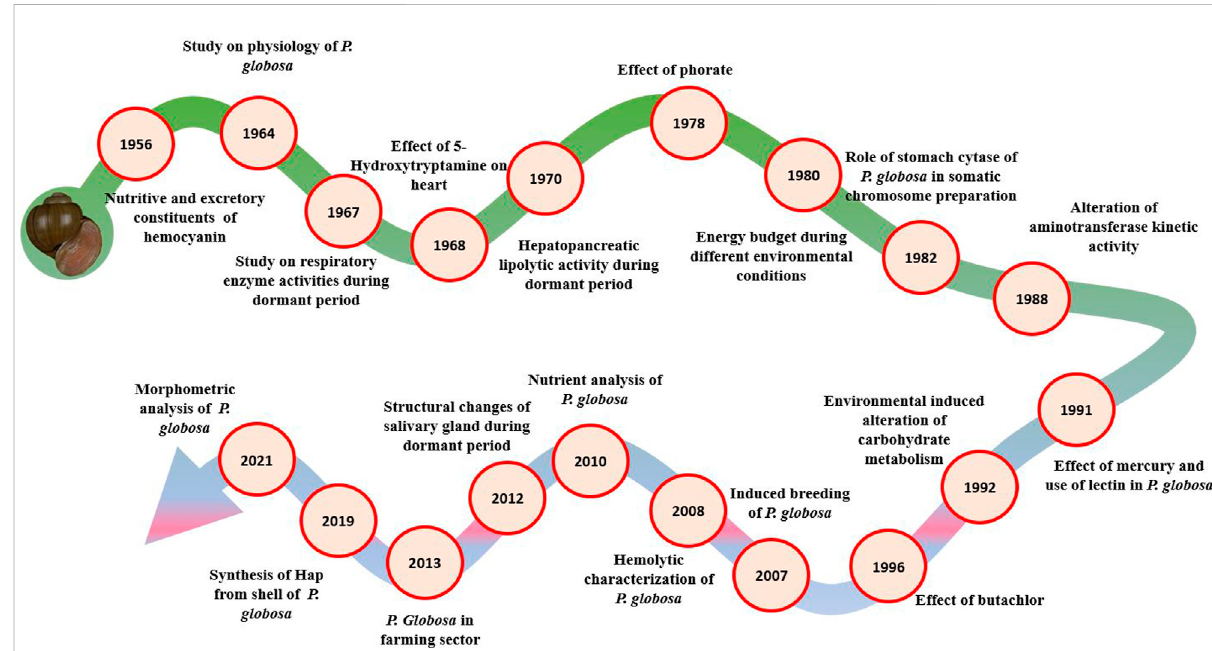
FIGURE 3 Chronology ofworksdoneondifferentaspectsof P.globosa. Mostoftheworkshavebeendoneonthealterationofexcretory patternsandthe effect of insecticides on P . globosa. P. globosa is thought to be originated from the African continents. Continental drift results in the dispersion of this species to oriental and Ethiopian regions. In the oriental region, it is found in India, Sri Lanka, Burma, Thailand, Indonesia, Malaya, Vietnam, and Philippines while habitats of the Ethiopian region include Africa, Arabia, and